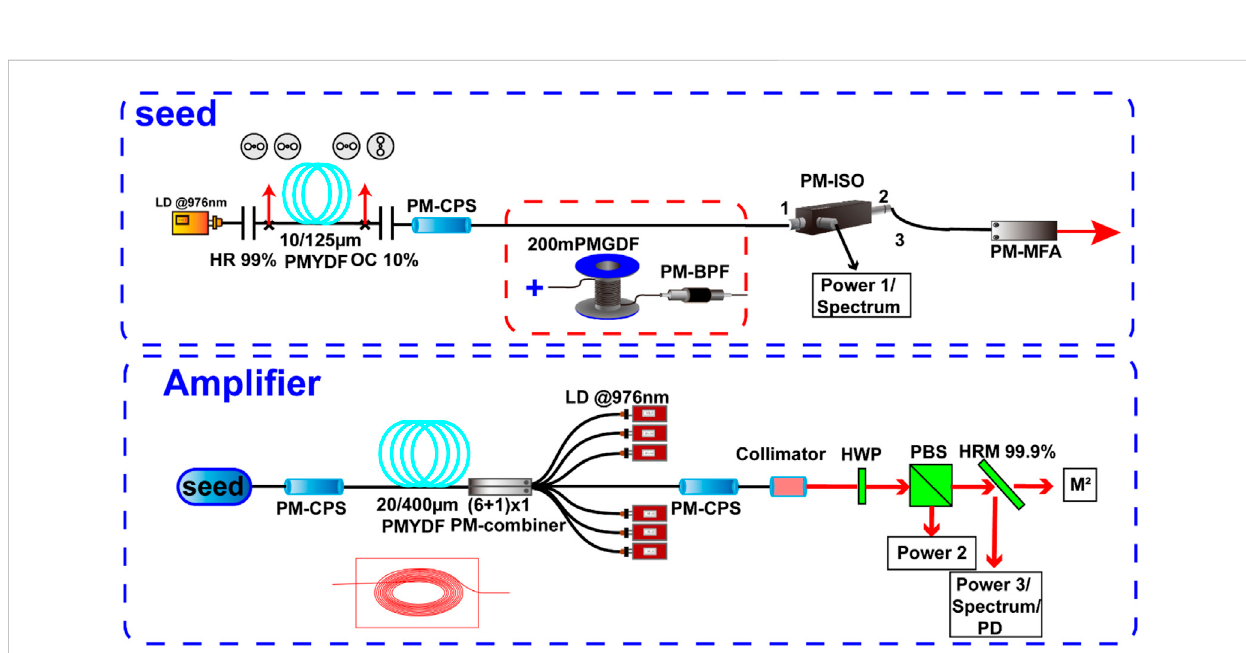
FIGURE 2 Scheme of experimental setup based on master oscillator power ampli fi er (MOPA). LD, laser diode; HR, high re fl ectivity fi ber Bragg grating; OC, output coupler fi ber Bragg grating; PM-CPS, polarization maintaining cladding power stripper; PMGDF, polarization maintaining Ge-doped fi ber; BPF, bandpass fi lter; ISO, isolator; MFA, mode fi eld adaptor; HWP, half-wave plate; PBS, polarization beam splitter; HRM, high re fl ection mirror; PD,